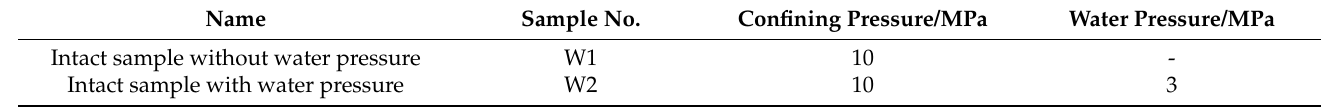
Table 2. Test scheme of intact sandstone